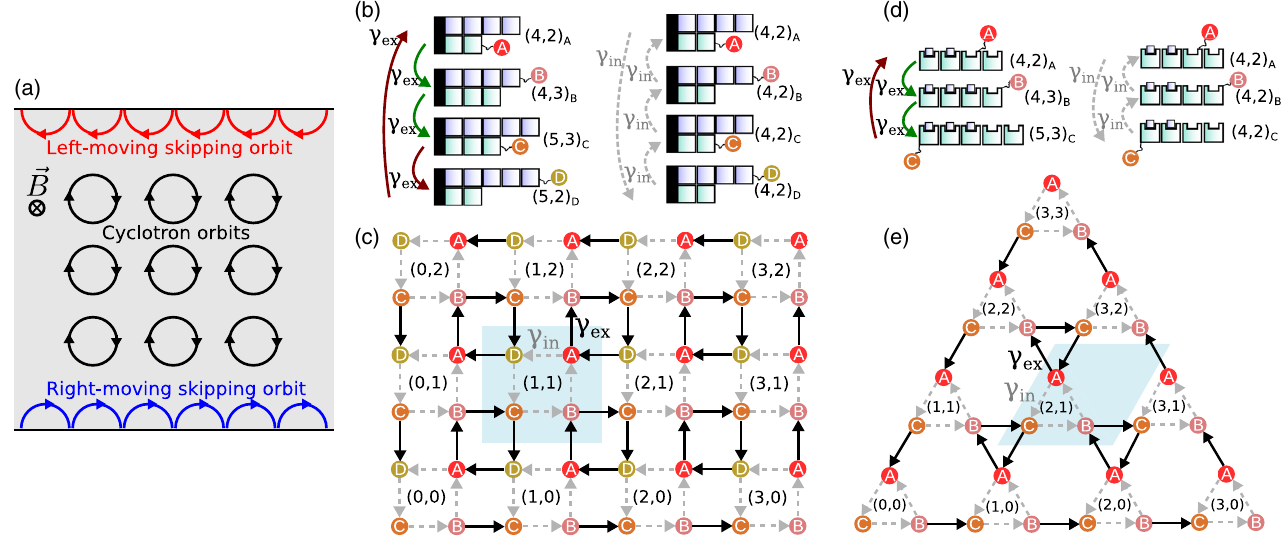
FIG. 1. Minimal motifs and resulting lattices. (a) Semiclassical picture of the quantum Hall effect, where cyclotron orbits of electrons ⃗ B in the bulk, with chirality defined by the perpendicular magnetic field , result in skipping orbits at the edges, giving oppositely directed currents at the top and bottom edges of the sample. (b) Four-state model for a structure composed of two types of monomers, X and Y (violet and green). The configuration of the system is determined by the number of monomers ð x; y Þ and the internal state (A, B, C, or D), and changes of the internal state are represented as tagging a given subunit and thus priming it for addition or removal. External transitions (governed by γ ) involve the addition (green arrows) or removal (red arrows) of subunits, whereas internal transitions (gray, ex γ ) cause relaxation of the internal state. (c) Square lattice corresponding to the four-state model. (d) Three-state model, describing a in system in which subunits X (green) are modified, e.g., via phosphorylation (violet). The external transition from C to A involves the removal (red arrow) of a modified subunit. (e) Kagome lattice corresponding to the three-state model. Note the similarity between the lattices (c,e) and the quantum Hall effect in panel (a), with clockwise external cycles (black, γ ) representing cyclotron orbits and ex internal transitions (gray, γ ) enabling diffusive translation of these orbits. The skipping orbits in panel (a) correspond to the in counterclockwise trajectory along the system boundary in panels (c,e). The shaded blue square and rhombus in panels (c) and (e), respectively, correspond to a unit cell in each